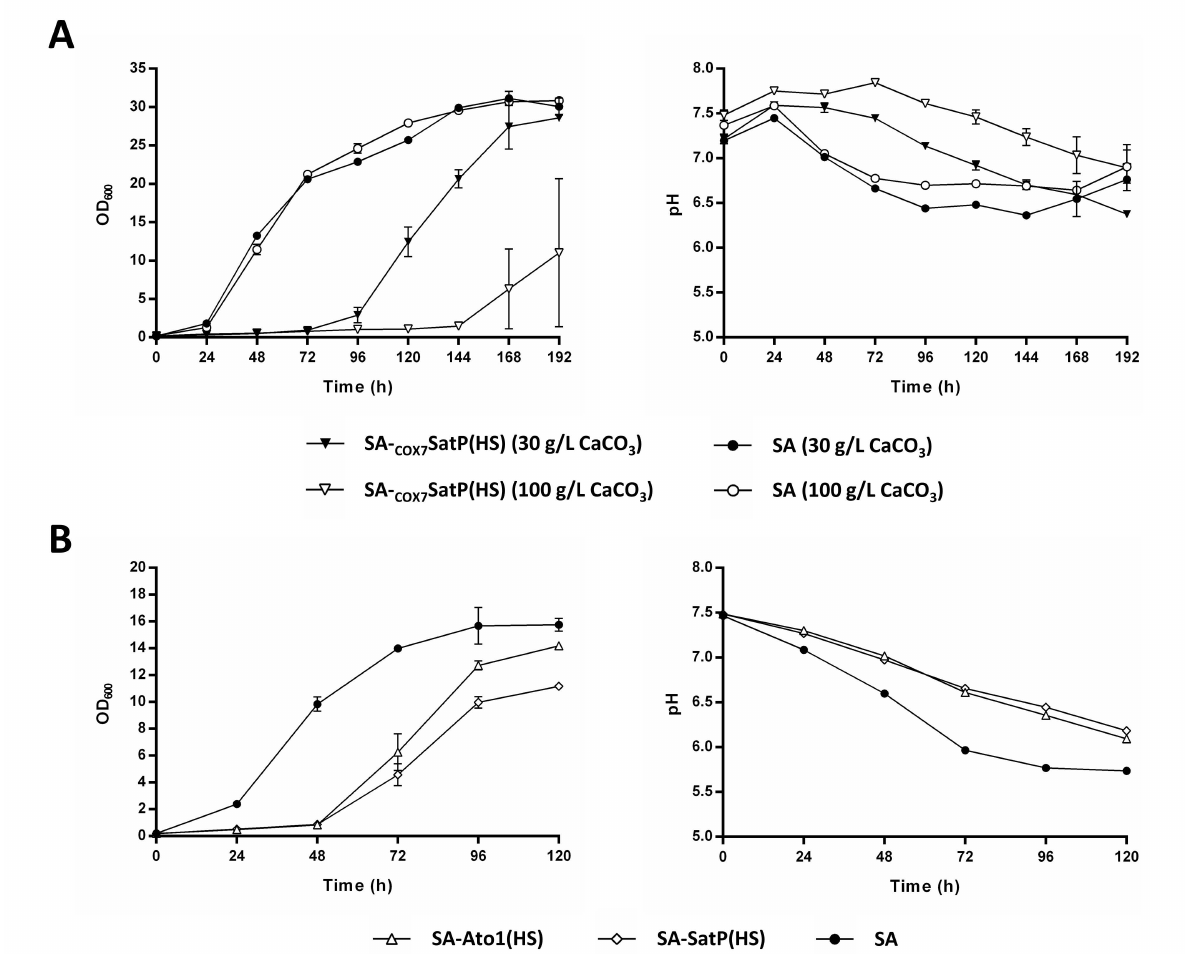
Figure 5. The prolonged lag phase in CaCO 3 -containing medium of the strains which expressed Ato1 E144A, L219A and SatP L131A seems to be a consequence of the increased pH. ( A ) Growth of the strains SA- COX7 SatP (HS) ( (cid:72) and (cid:53) ) and SA ( • and ) in synthetic glycerol medium using urea as (cid:35) the nitrogen source and buffered with two different concentrations of CaCO 3 : 30 g/L ( (cid:72) and • ) and 100 g/L ( (cid:53) and ) (see composition in materials and methods). The initial pH of the medium prior (cid:35) to CaCO 3 addition was set to 7.0. ( B ) Growth of the strains SA-Ato1 (HS) ( (cid:52) ), SA-SatP (HS) ( ), (cid:51)